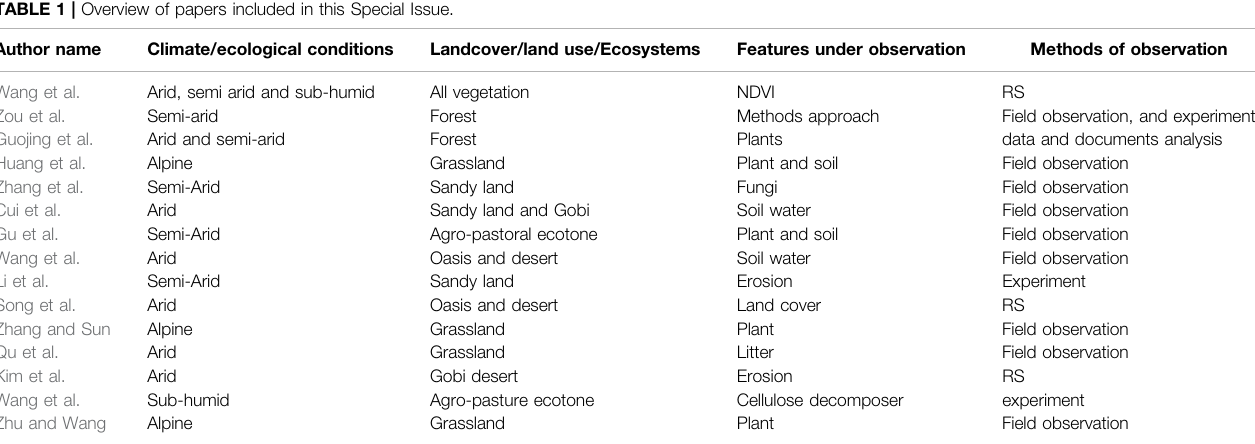
TABLE 1 | Overview of papers included in this Special